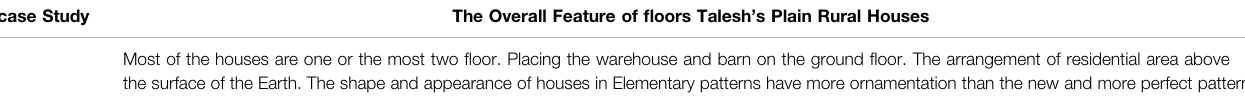
TABLE 2 | pictures of the 150 selected Talesh ’ s rural homes, Source: